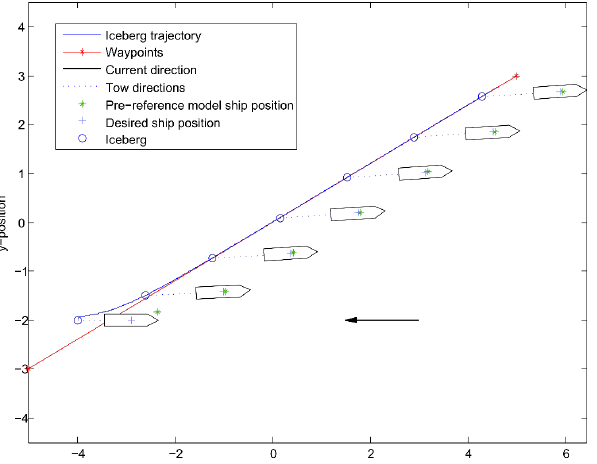
Figure 13: Iceberg towing in ocean current. The blue circles are the location of the iceberg at dif- ferent instants of time. The iLOS algorithm ensures that a correct towline direction is enforced. Courtesy: Orsten et al.